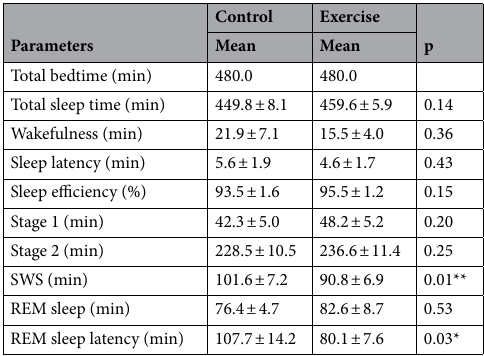
Table 2. Sleep Architecture (mean ± standard error). SWS slow-wave sleep, REM rapid eye movement. * p < 0.05, ** p <